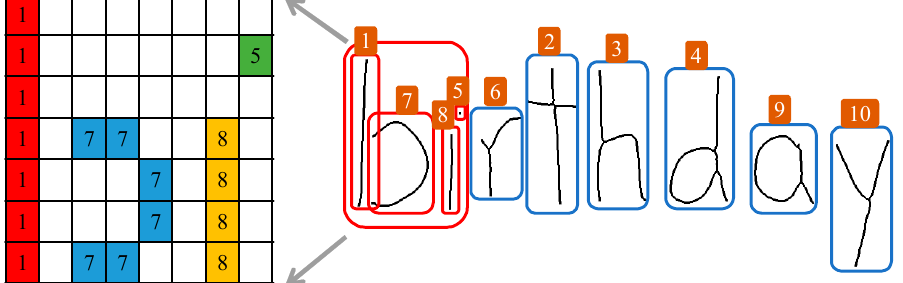
Figure 4. Illustration of connected components labelling with sample table of labels for two characters, bi.